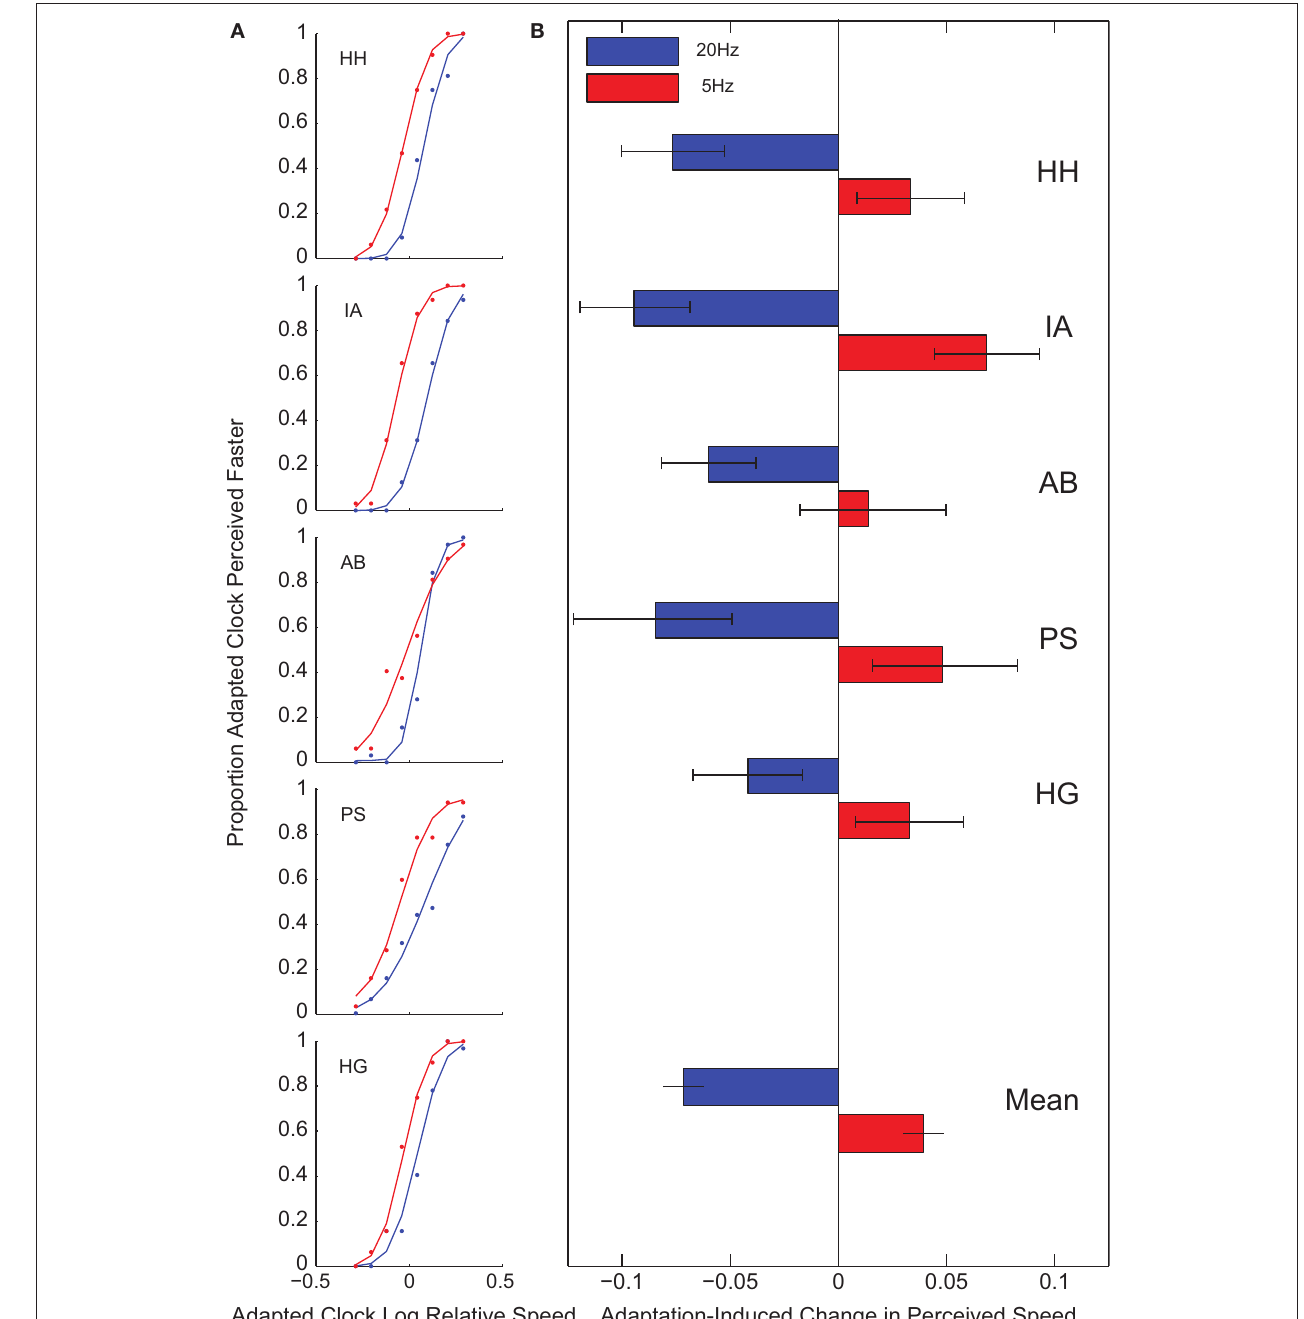
Figure 3 | Perceived speed. In Experiment 2, observers reported which of two clocks appeared to move faster. A 20-Hz adaptation caused a clock in an adapted region to appear to move more slowly than a clock in an unadapted region, and 5-Hz adaptation caused a clock to appear to move more quickly.